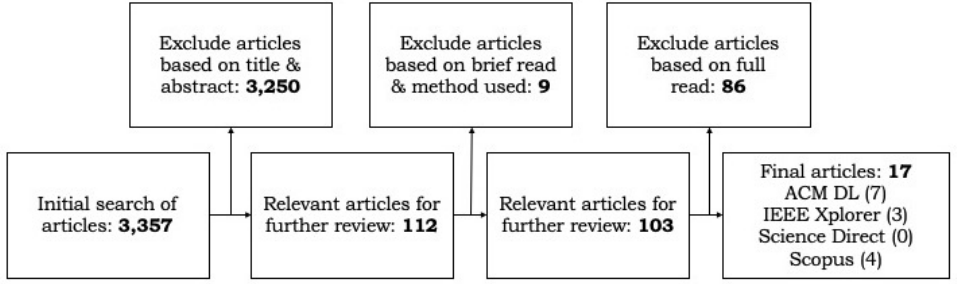
Figure 1. Articles are filtered through by three selection steps, namely a selection based on title and abstract, a selection through quick reading, and a selection through a full